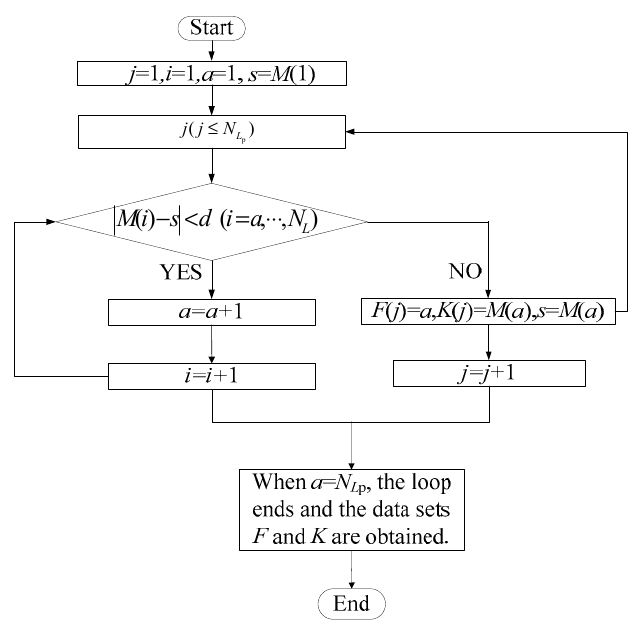
Figure 12. Flow chart of the algorithm.